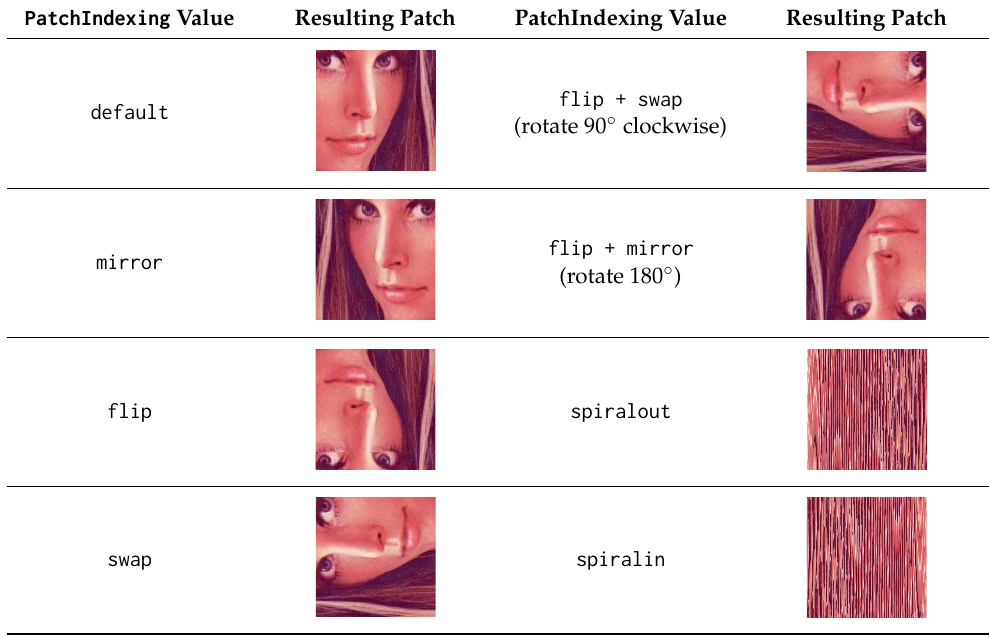
Table 5. Examples of patch indexing operations when applied to a 128 × 128 patch.